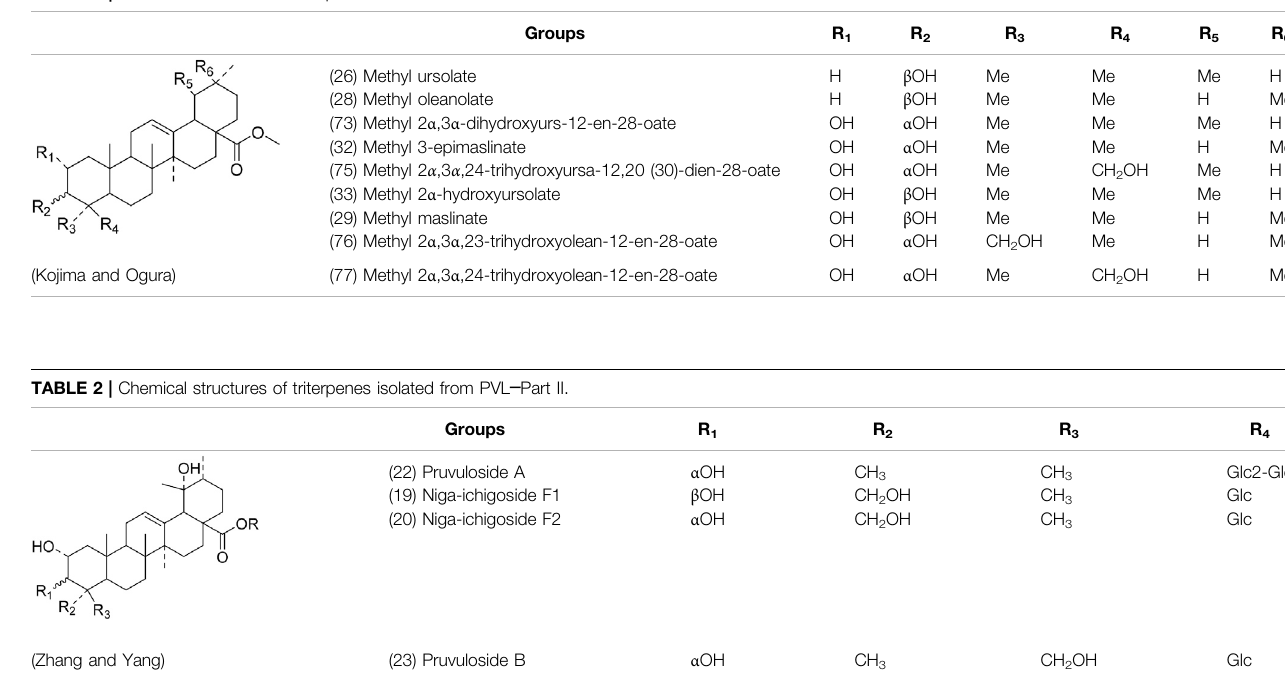
TABLE 1 | Chemical structures of triterpenes isolated from PVL ─ Part I.